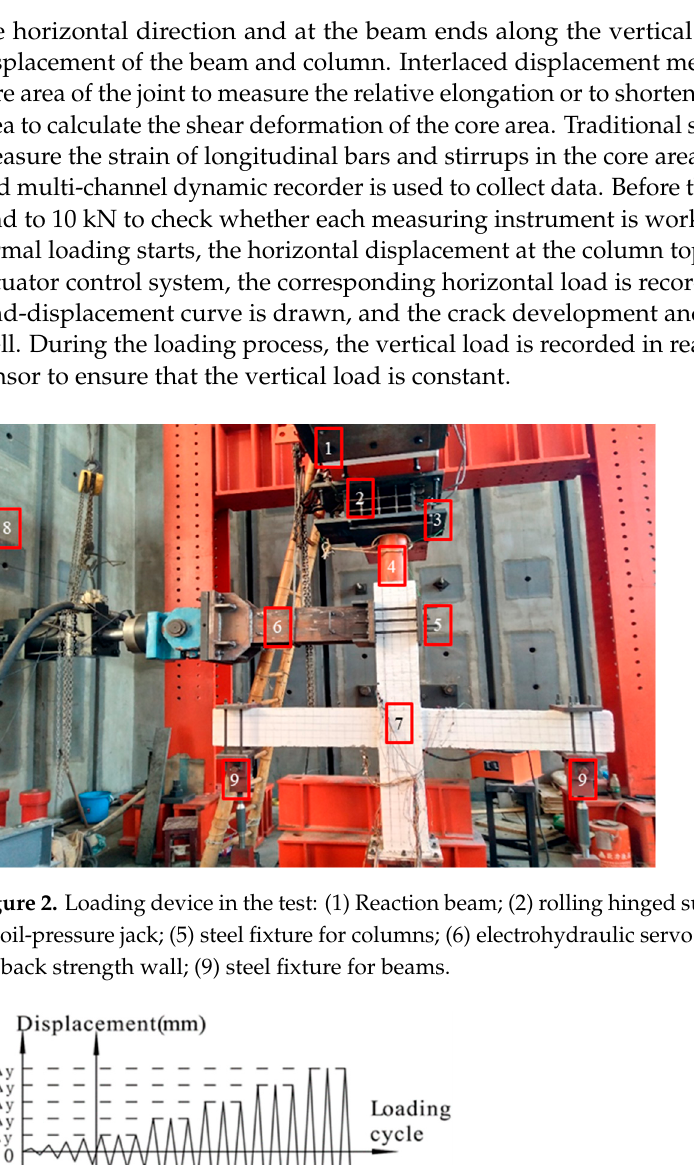
Figure 2. Loading device in the test: (1) Reaction beam; (2) rolling hinged support; (3) pressure sensor; (4) oil-pressure jack; (5) steel fixture for columns; (6) electrohydraulic servo actuator; (7) concrete joint; (8) back strength wall; (9) steel fixture for beams.